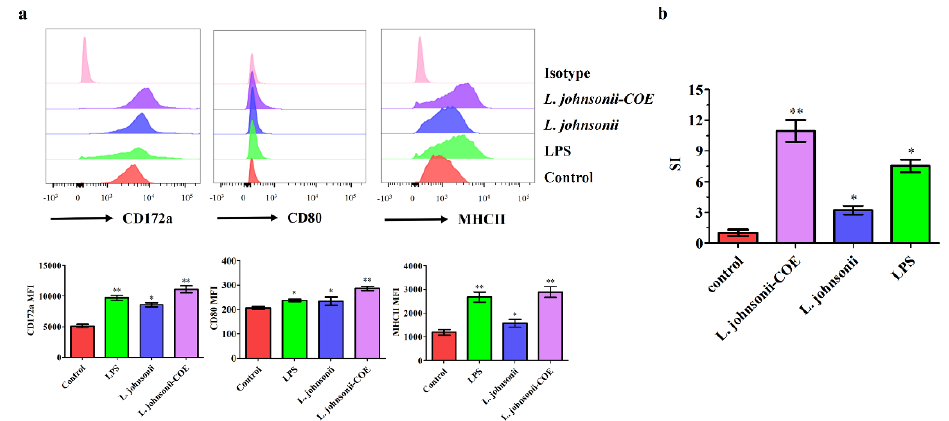
Figure 4. Analysis of surface markers and CD4 + T cells proliferation in MoDCs stimulated by L. johnsonii – COE , LPS (200 ng mL -1 ), and L. johnsonii . ( a ) The expression of CD172a, CD80, and MHCII on MoDCs were detected via flow cytometry, and the mean fluorescence intensity (MFI) values of represent three molecules are exhibited as mean ± SD values; ( b ) analysis of proliferation of differently treated MoDCs induced CD4 + T cells. * ( p < 0.05) and ** ( p < 0.01).